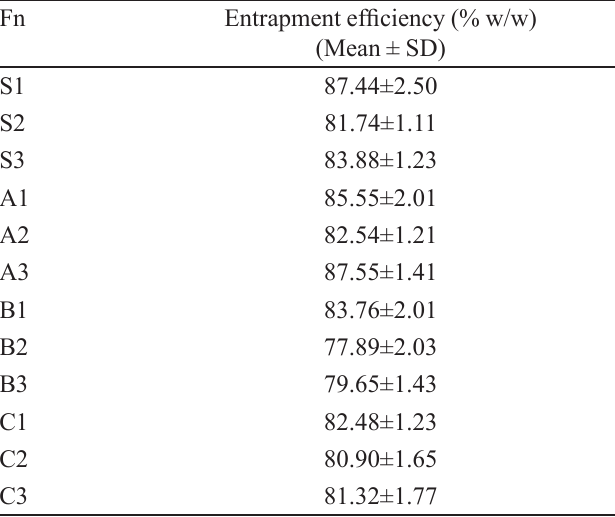
TABLE III - Entrapment efficiency of microspheres Fn